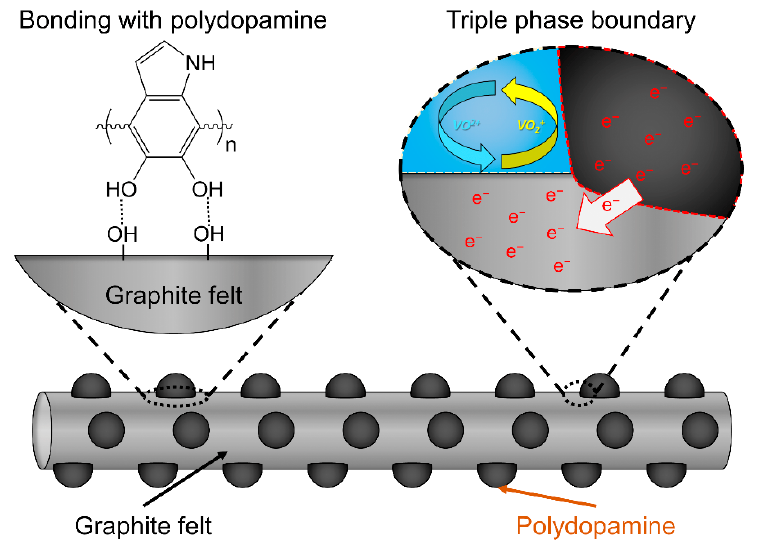
Figure 10. Mechanisms of synergistic effects on functionalization and coating processes of polydopamine on GF substrates by APPJ for enhancing the VRFB performance.